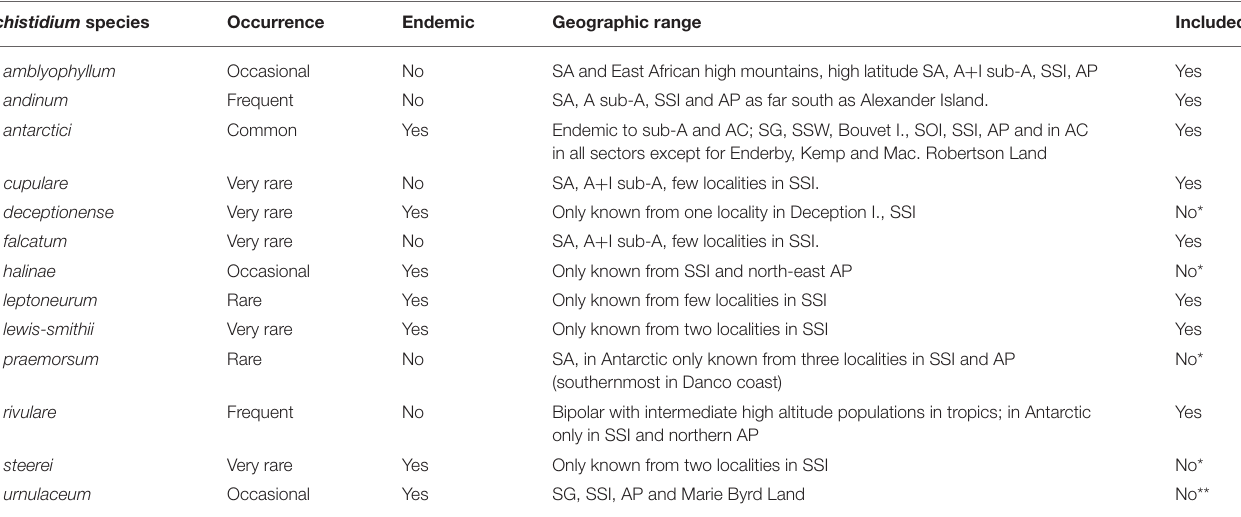
TABLE 1 | Information on geographic range, endemic status and occurrence of Antarctic Schistidium species (based on Ochyra et al., 2008), and inclusion in the current study. Schistidium species